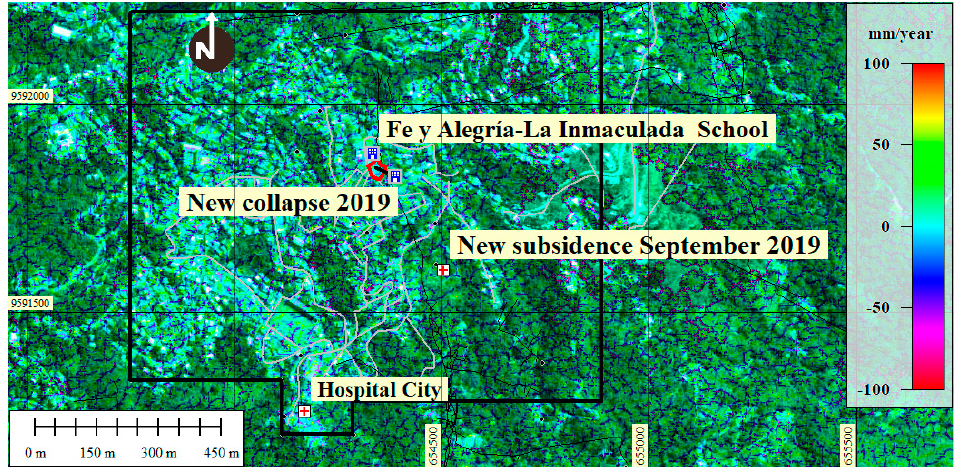
Figure 12. Determination of the “traces” (blue stripes) of connections of unmapped mining galleries. These galleries, generally illegal and abandoned, are connected to mineralized veins and legal mapped galleries, breaking the balance of the rock mass, intensifying the subsidence of the topographic surface of the sector.